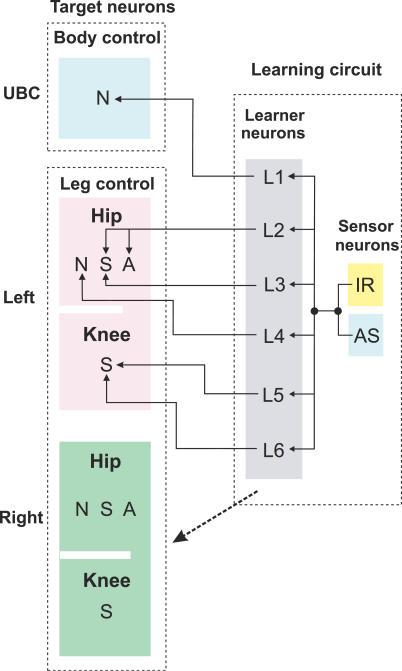
Postural Neuronal ControlConnections between learner neurons and target neurons of the right leg, which are identical to those of the left leg, are not shown (see text and also Materials and Methods for details).